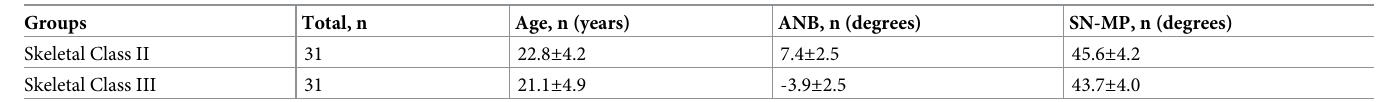
Table 1. Distribution of samples.